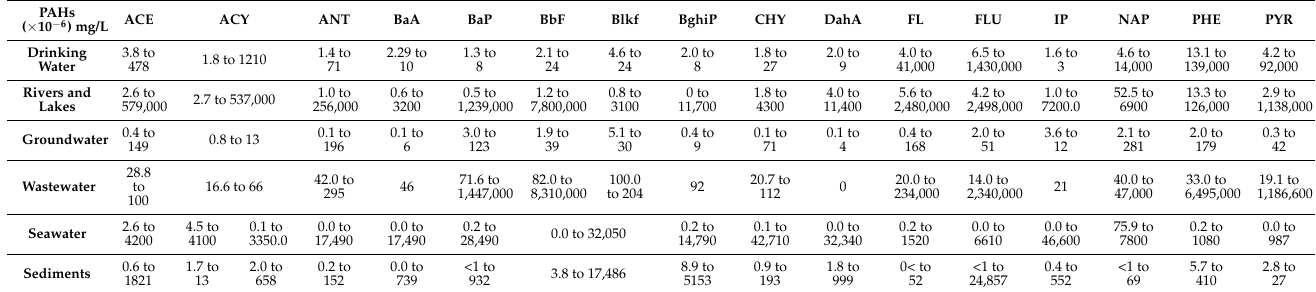
Table 3. The PAHs content in various water sources. Reprinted/adapted with permission from